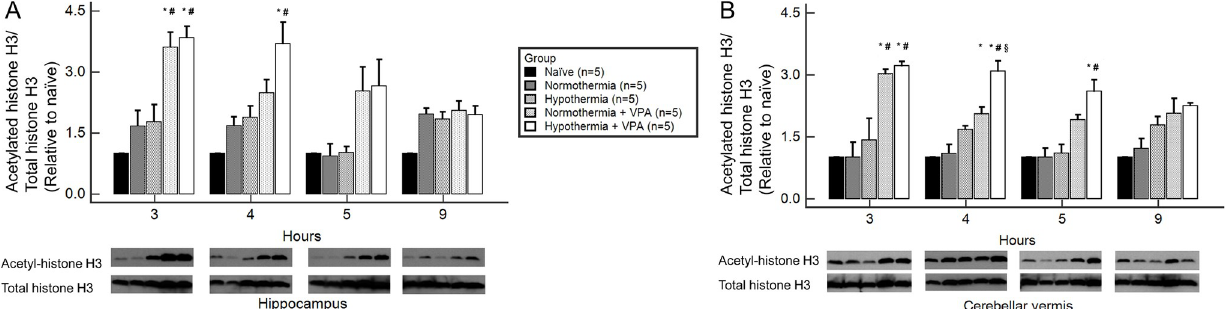
Fig 3. Acetylated histone H3 of regional brain homogenates obtained at 3, 4, 5, and 9 hours after ROSC by Western blot analysis. At three hours after ROSC, VPA-administered groups (normothermia + VPA, hypothermia + VPA) showed significantly higher levels of acetylated histone H3 level than non- VPA-administered groups both in the hippocampus (A) and the cerebellar vermis (B). Bars represent mean ± SEM. Intergroup comparison was performed by one-way analysis of variances with Scheffe´ post-hoc analysis. � , p < 0.05 versus normothermia; # , p < 0.05 versus hypothermia; § , p < 0.05 versus normothermia +